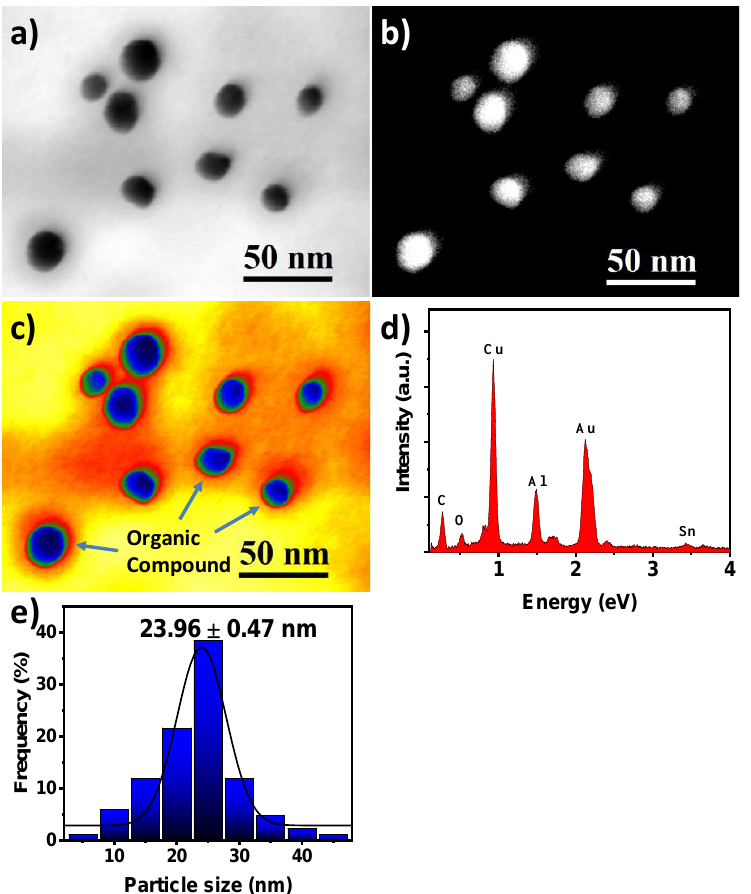
Figure 3. STEM micrographs of AuNPs synthesized using Sargassum spp., ( a ) BF-STEM image, ( b ) ADF-STEM image, ( c ) CLUT image, ( d ) EDS analysis, and ( e ) the corresponding histogram of particle size distribution.